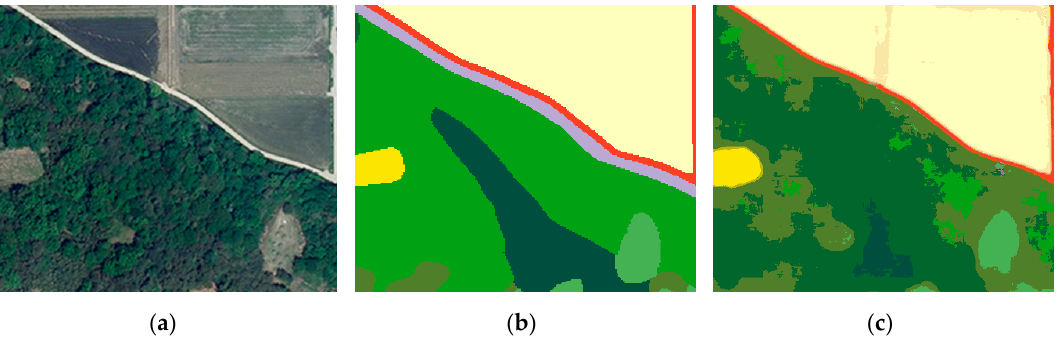
Figure 9. Example of ambiguity of land cover in grassland (yellowish green and whitish green is grass land, other greens are forest with different types of tree, yellows are agricultural area, and red is road). ( a ) Orthographic image, ( b ) Land cover map, ( c ) Classification result. Remote Sens. 2020 , 12 , x FOR PEER REVIEW